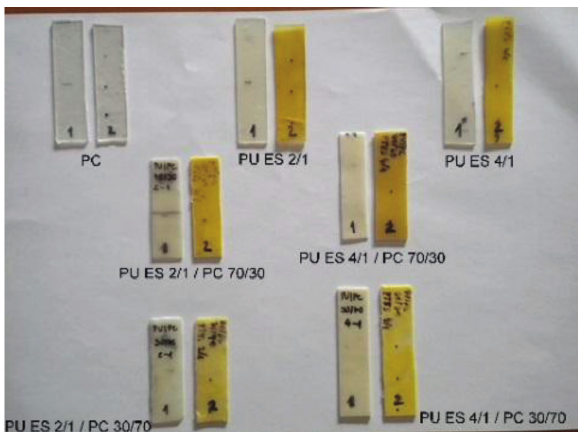
Fig. 1 – Photographs of samples before (1) and after (2) UV